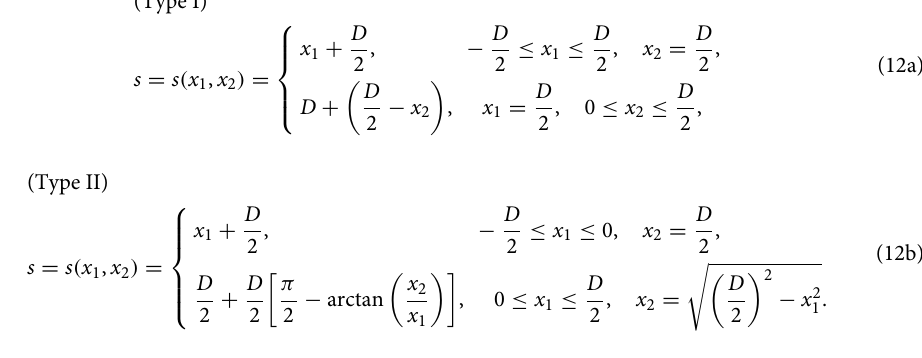
F 1 with respect to the Knudsen number Kn for various − 1 =